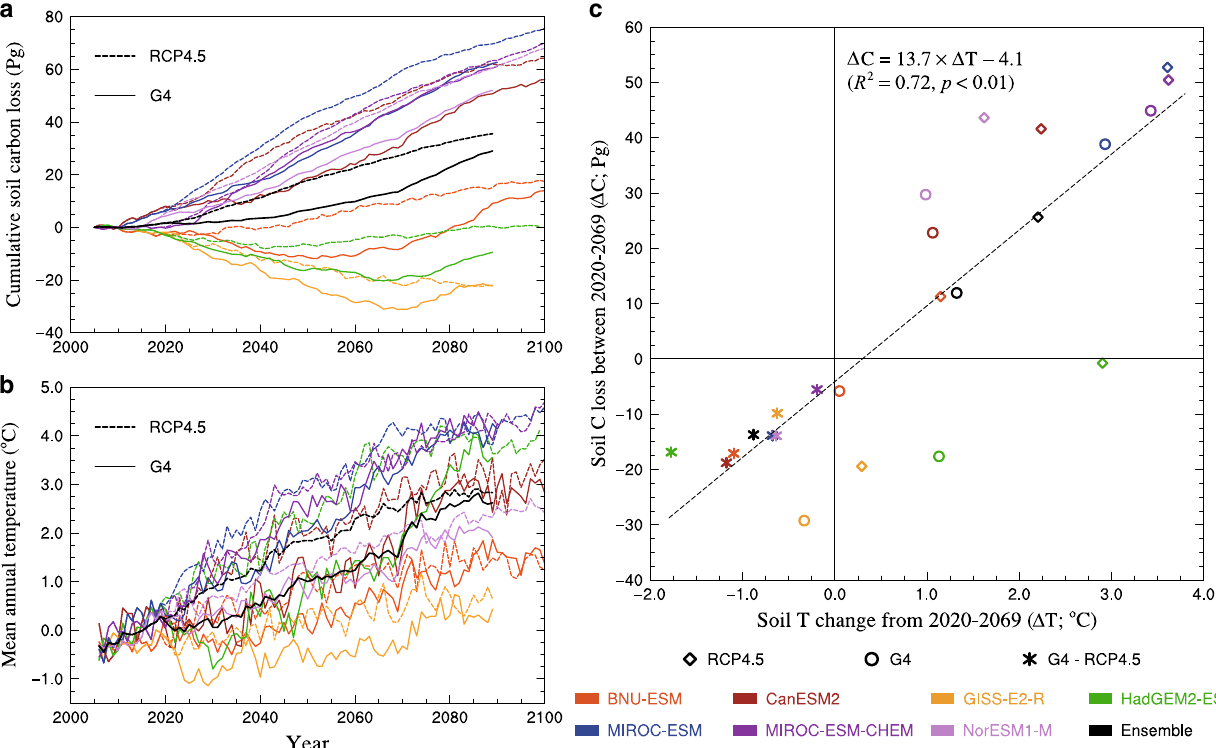
Fig. 1 Soil temperature change and permafrost carbon loss over time. a Cumulative losses of circum-Arctic permafrost C storage from PInc-PanTher between 2006 and 2100 under the emission scenario RCP4.5 and the geoengineering experiment G4; each curve is the mean of two methods of calculation (Supplementary Fig. 1; Methods). b Mean annual temperature in the upper 3 m of soils, derived from bias-corrected ESM outputs (Table 1). c Scatter plot of permafrost C loss and soil T change during SAI implementation (2020-2069); positive values of permafrost C loss indicate losses of soil C stocks to atmosphere. ESMs vary greatly in initial conditions, as they are not tuned for their long-period ocean-atmosphere-sea ice cycles to match the observations on decadal scales. Therefore, we perform the initial bias-correction and utilize ensemble